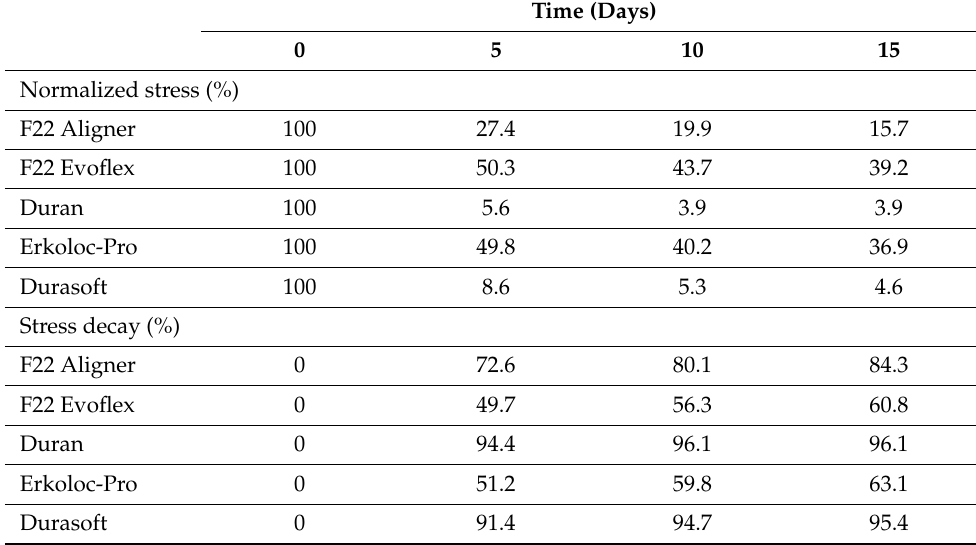
Table 4. Normalized stress relaxation